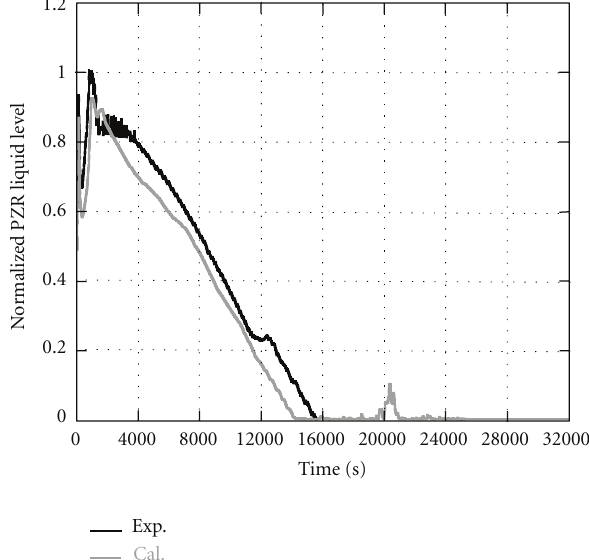
Figure 10: LSTF and RELAP5 results for PZR liquid level.